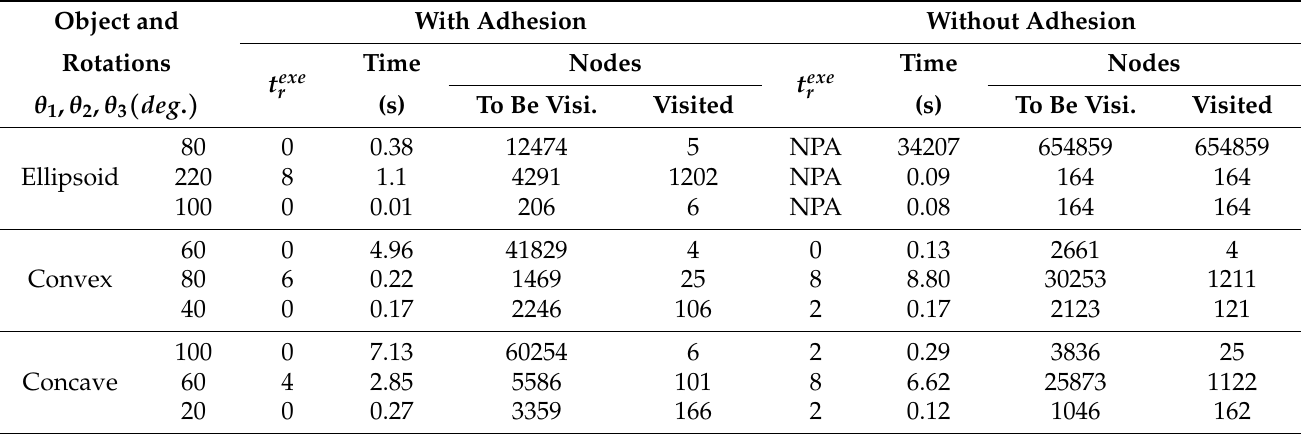
Time Nodes t exe r